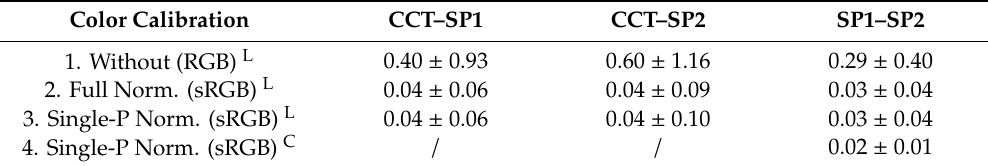
Table 2. Absolute differences in EI BRG between CCT’s referential data and both smartphones’ estimates (SP1, SP2) with different EI color calibration procedures. 1: EI was calculated directly from the device-dependent SP1′s and SP2′s RGB color spaces, 2: Colorimetric data was transformed to the standard RGB color space (sRGB) by the full normalization on six grayscale patches, 3 and 4: Colorimetric data was transformed to the standard RGB (sRGB) color space by the single-point normalization on the brightest white CCT patch (No. 19).